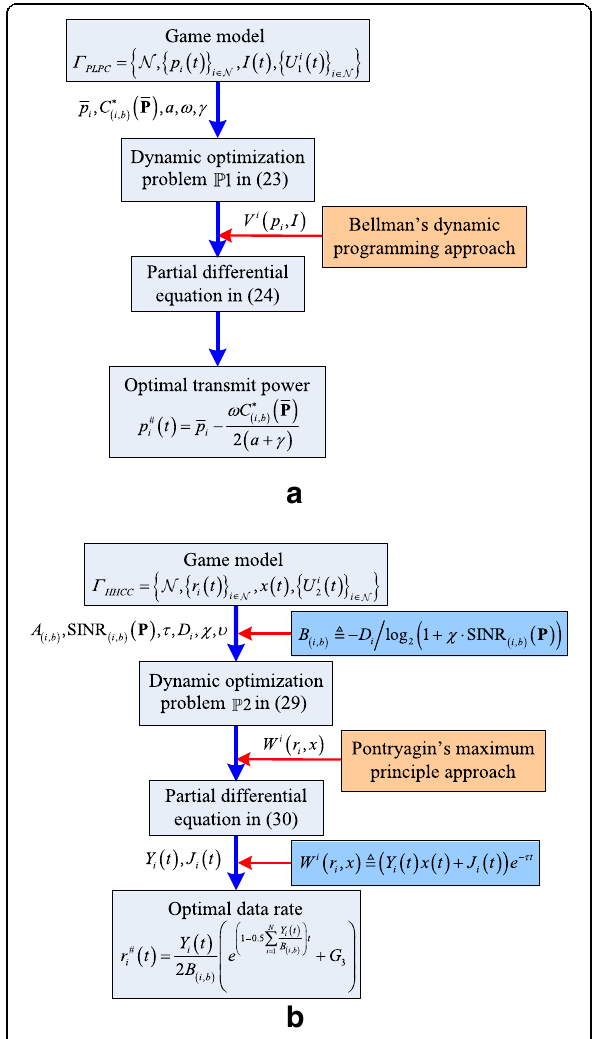
Fig. 4 The block diagram of the dynamic optimization problems ℙ 1 and ℙ 2 coupled with their optimal solutions: a optimal solution to Γ Γ PLPC and b optimal solution to